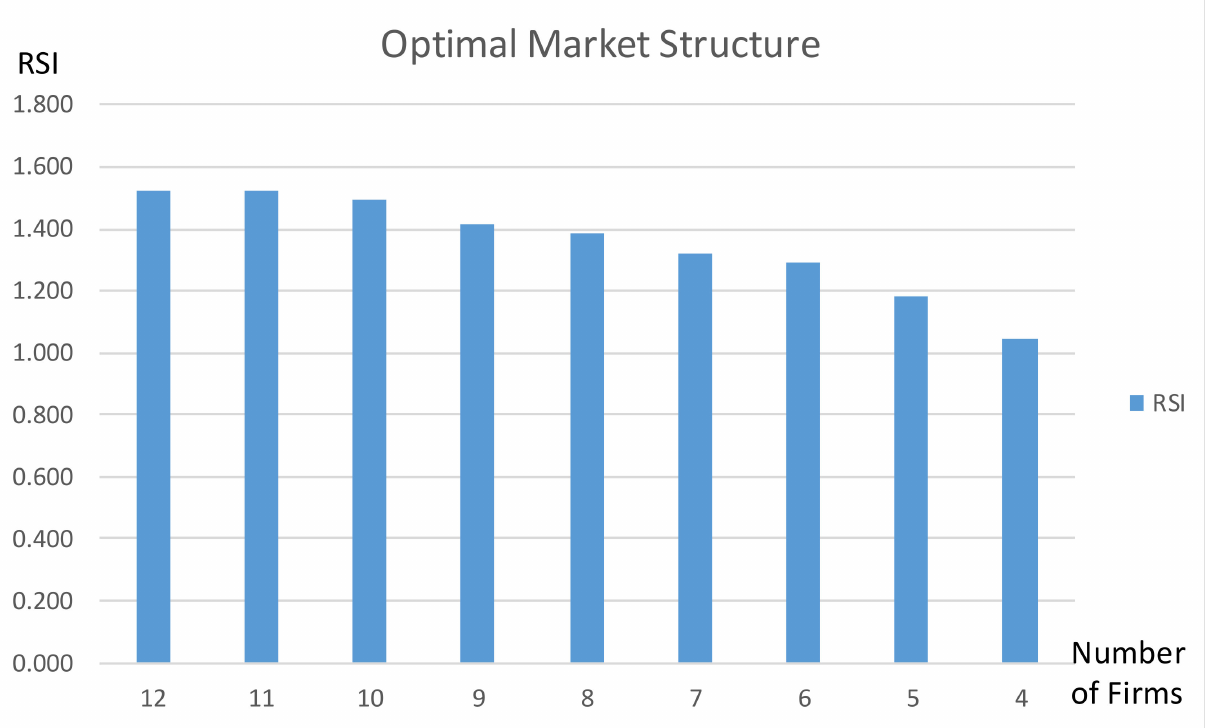
Figure 4. Optimal market structure case